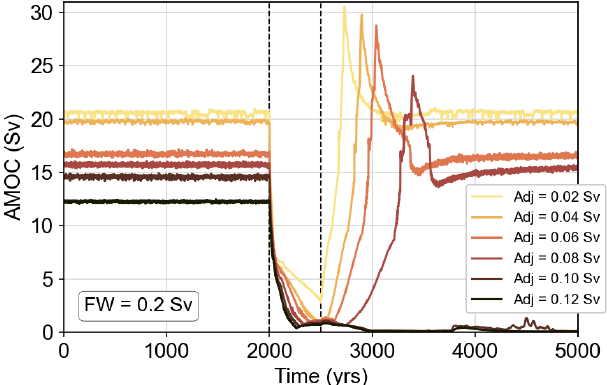
Figure 6. Sensitivity of weakened AMOC states of LGM_BS + wind + tidal boundary conditions to